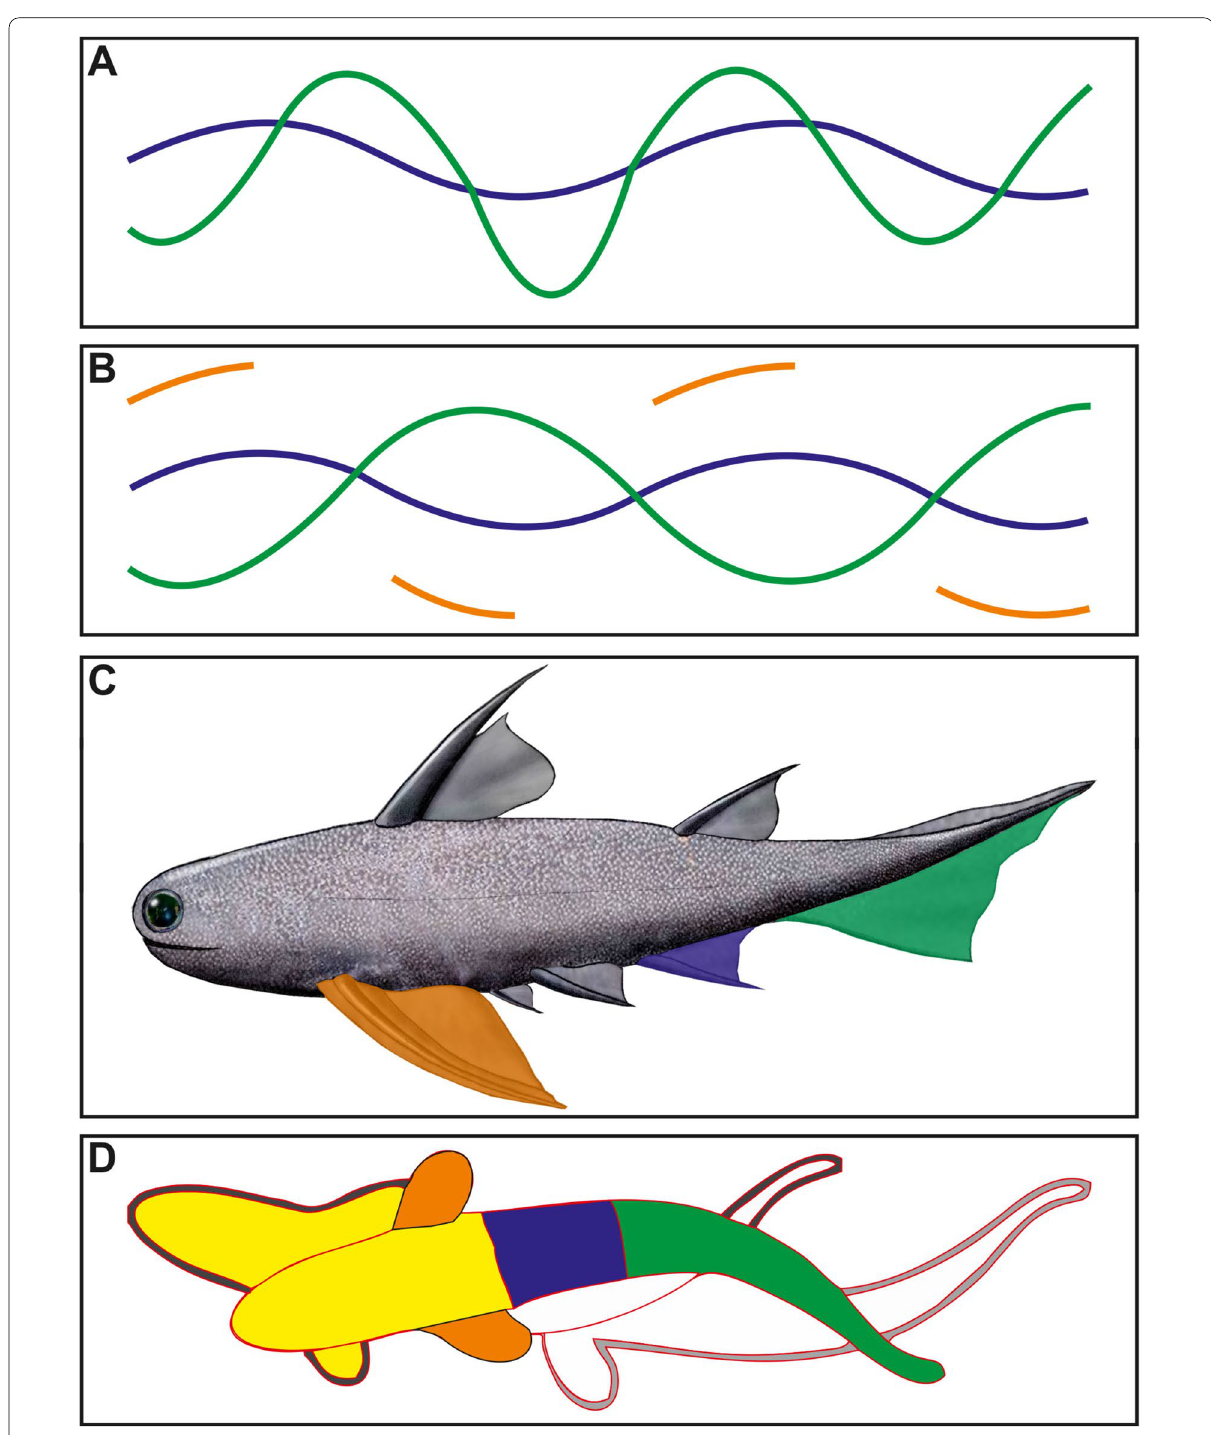
Fig. 6 A , B Interpretative drawing of the two morphotypes of the ichnospecies Undichna britannica. C Schematic sketch of the anatomical features of a potential tracemaker (here an acanthodian as example). D Mode of movement based on the anatomical-controlled features recorded within the described Undichna britannica from